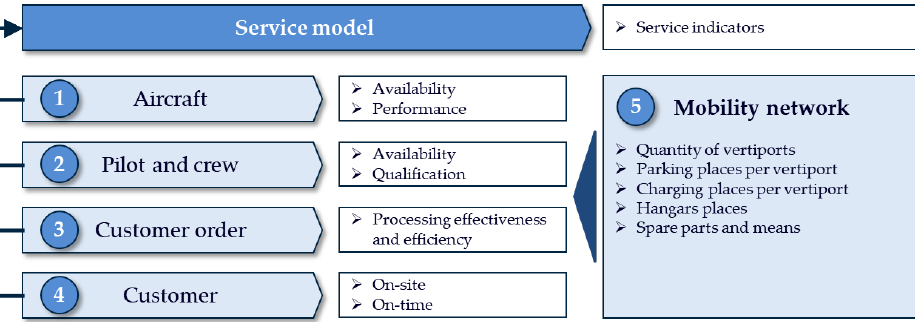
Figure 8. Service model and its five elements.